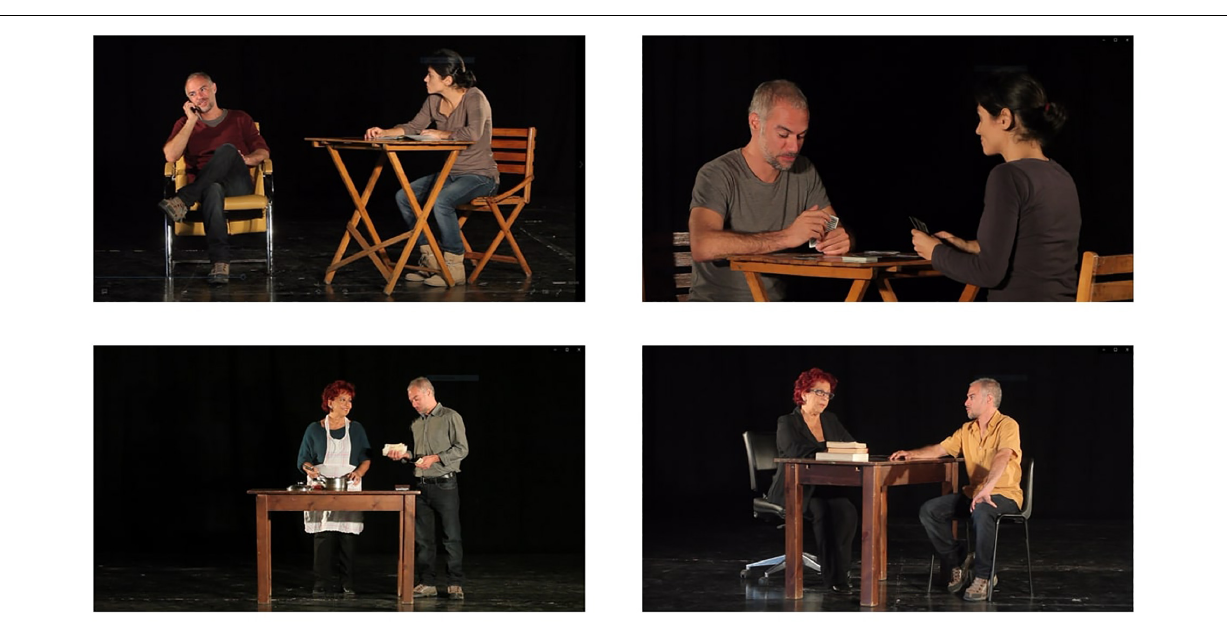
FIGURE 2 | Frames of social interaction’s